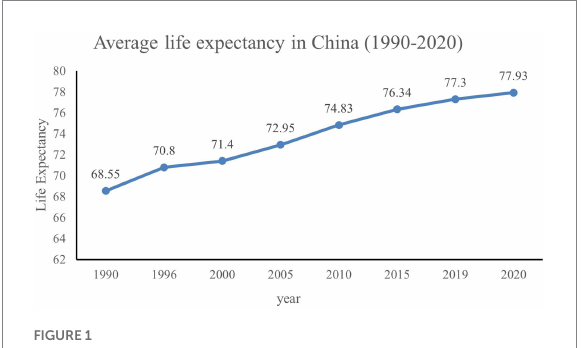
FIGURE 1 Average life expectancy in China (1990–2020). Data obtained through the National Bureau of